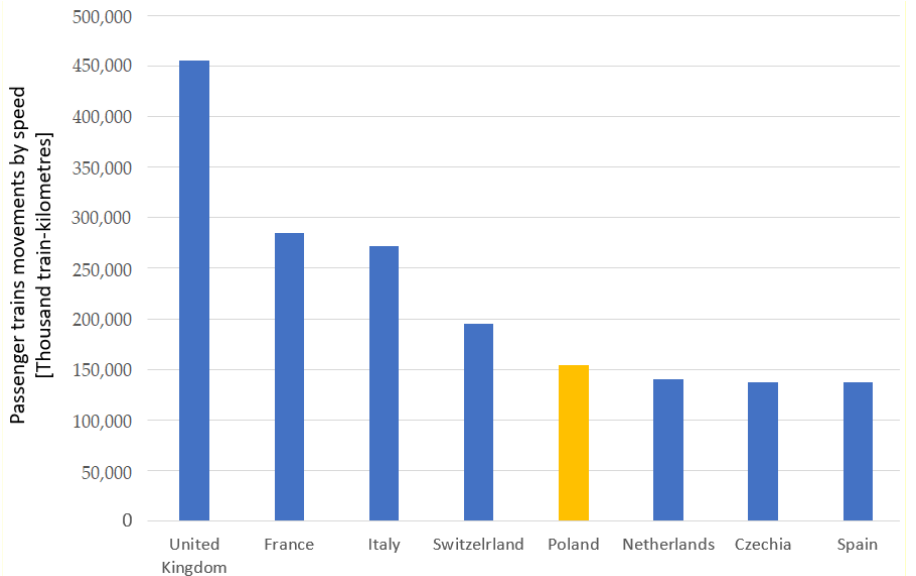
Figure 9. Correlation of the overall passenger train traffic versus speed in 2020. Yellow colour — Poland; blue colour — other European countries.